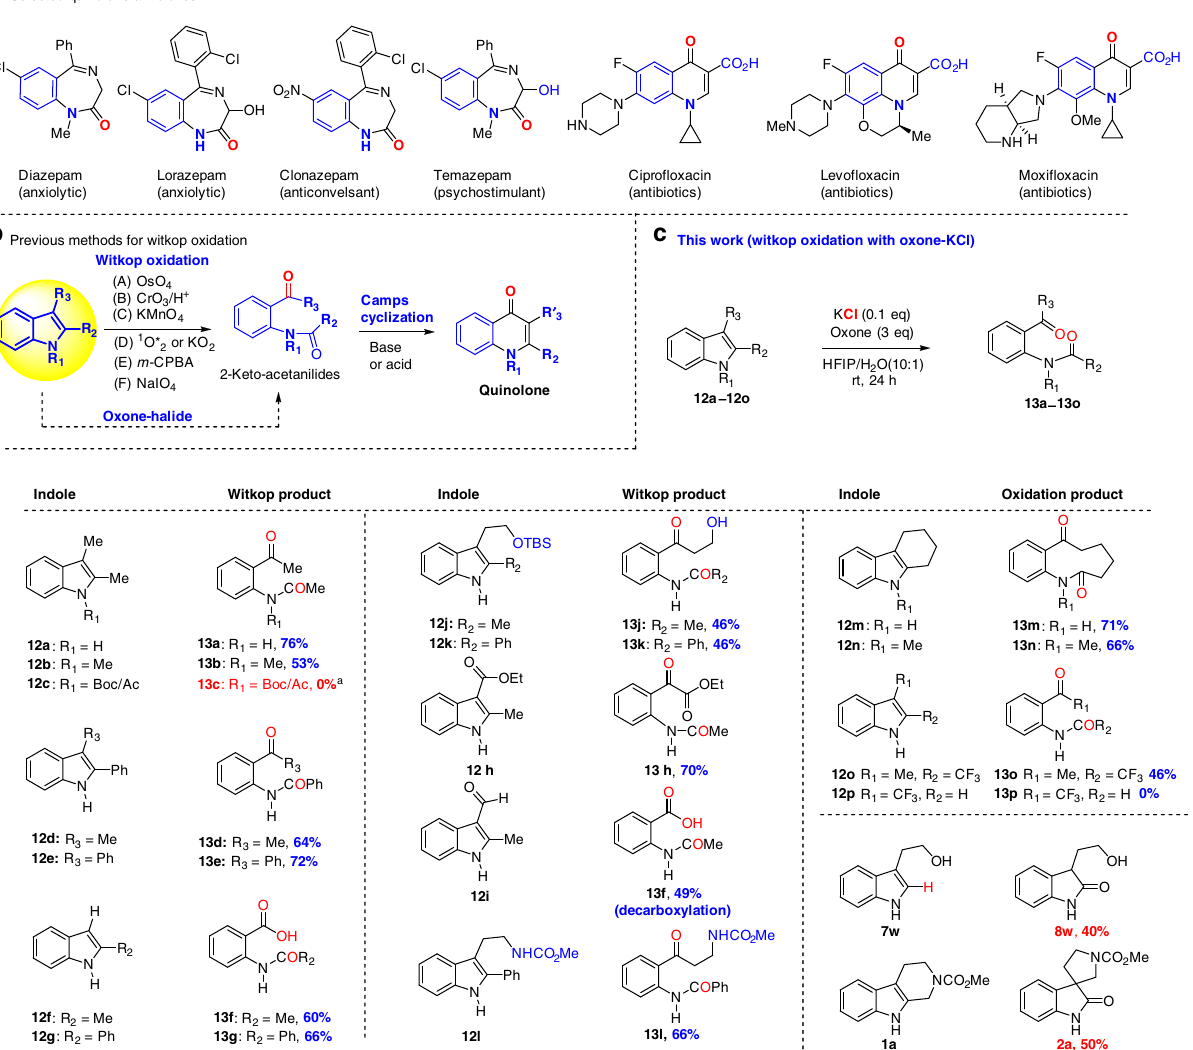
Fig. 6 Quinolone antibiotics and Witkop oxidation. a Selected quinolone antibiotics. b Previous methods for Witkop oxidation. c Witkop Oxidation with Oxone-KCl (This